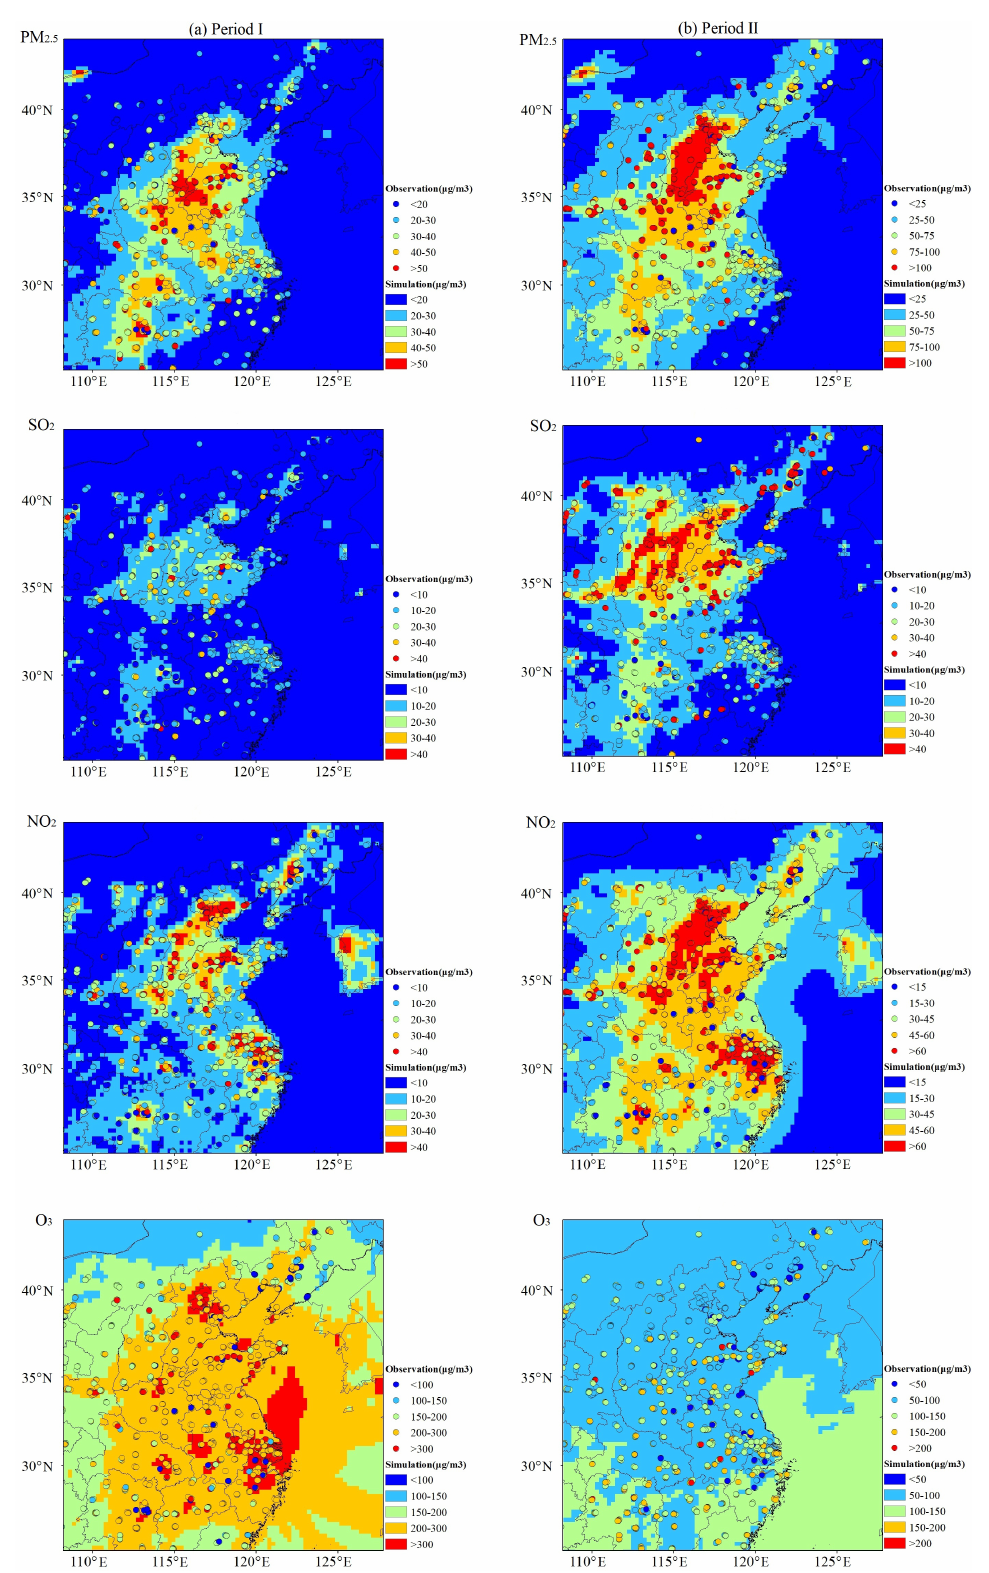
Figure 2. Spatial patterns of the surface average PM 2 . 5 , NO 2 , SO 2 and daily-maximum O 3 concentrations in Period I (a) and Period II (b) from the WRF-Chem modeling (shaded contours) and routine air quality observations